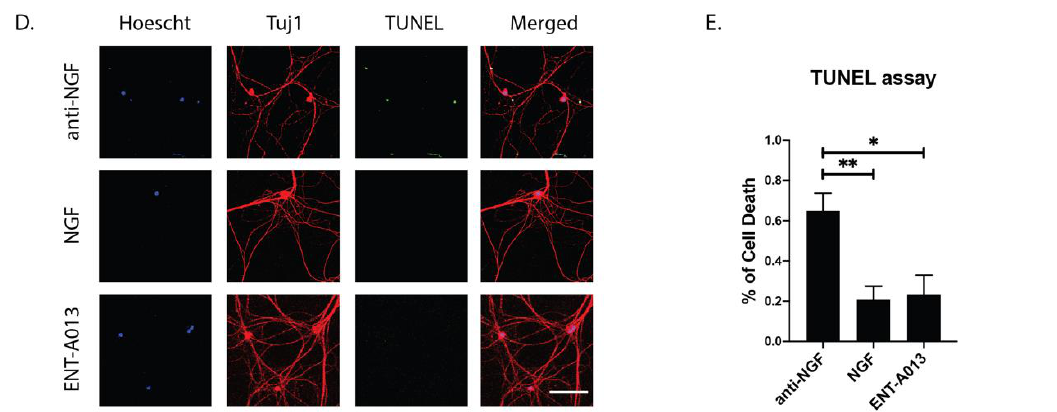
Figure 4. ENT-A013, ENT-A013E and ENT-A013Z protect PC12 cells against serum deprivation- induced cell death in a TrkA-dependent manner. PC12 cells were starved of serum and treated with NGF, ENT-A013, ENT-A013E, ENT-A013Z or vehicle in the presence or absence of a specific TrkA inhibitor GW441756 for 24 h and CellTox assay was used to quantify cell death. CellTox positive cell number was normalized to total Hoescht positive cell number in each image. Representative images from 4–9 independent experiments are shown ( A ) and quantification ( B ). Data represent ± SEM. One-way ANOVA, Tukey’s test correction: ns: non-significant; * and # p < 0.05; ** and ## p < 0.01; *** and ### p < 0.001; **** p < 0.0001. ( C ) Dose–response curve. IC 50 value of compounds ENT-A013, ENT-A013E and ENT-A013Z calculated at 166.72 nM, 281.19 nM and 272.89 nM, respectively. ( D , E ) Primary DRG neurons were treated for 48 h with ENT-A013 in the absence of NGF and in the presence of an anti-NGF neutralizing antibody. TUNEL assay was used to assess neuronal cell death. Representative images from 3–5 independent experiments. Data are shown as ± SEM. One-way ANOVA, Tukey’s Test correction: * p < 0.05; ** p <